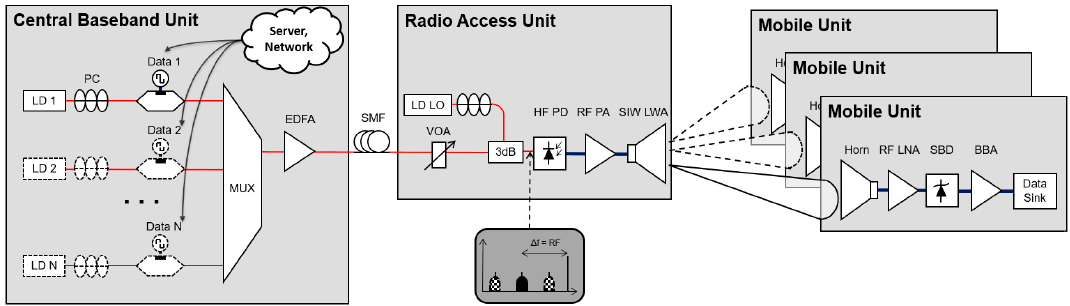
Figure 10. Proposed radio-over-fiber (RoF) based architecture for serving multiple mobile users via an optical dense WDM scheme and the presented SIW leaky-wave antenna.